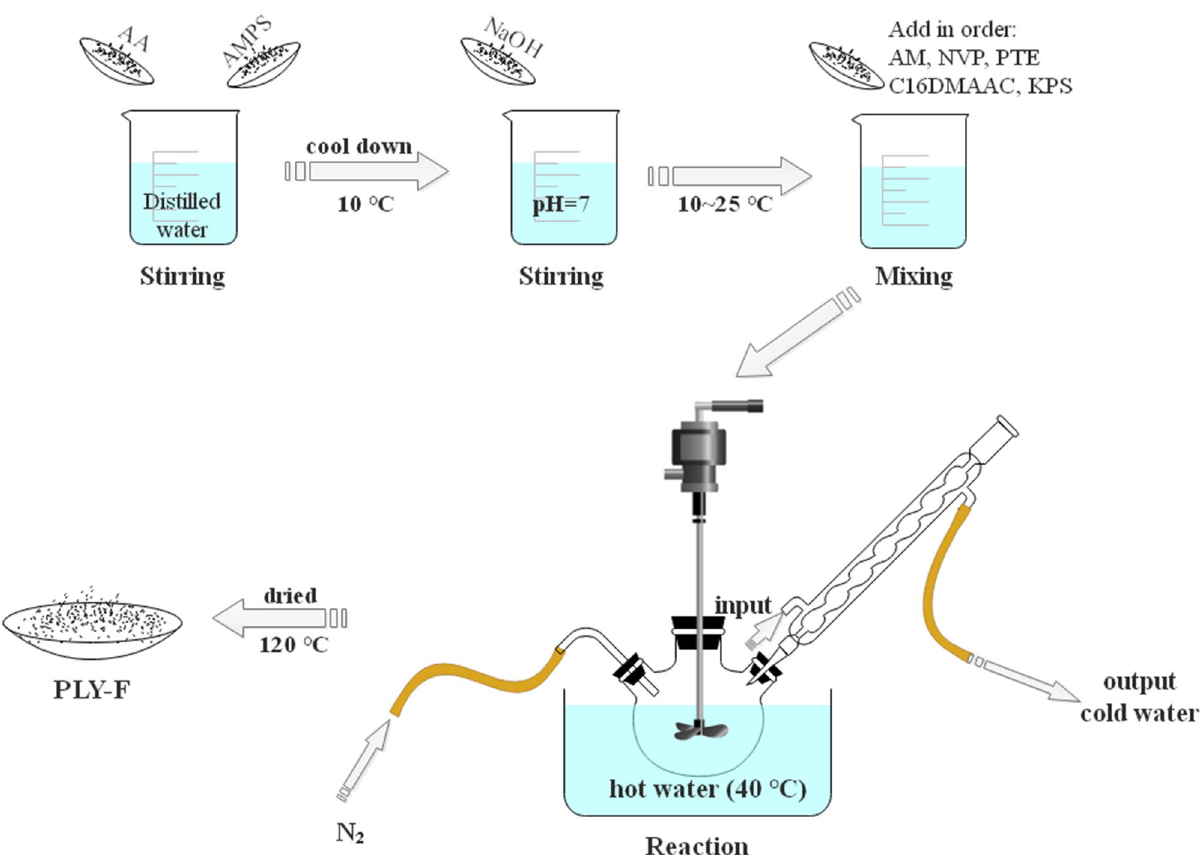
Figure 2. The prepare methodology flow of PLY-F of